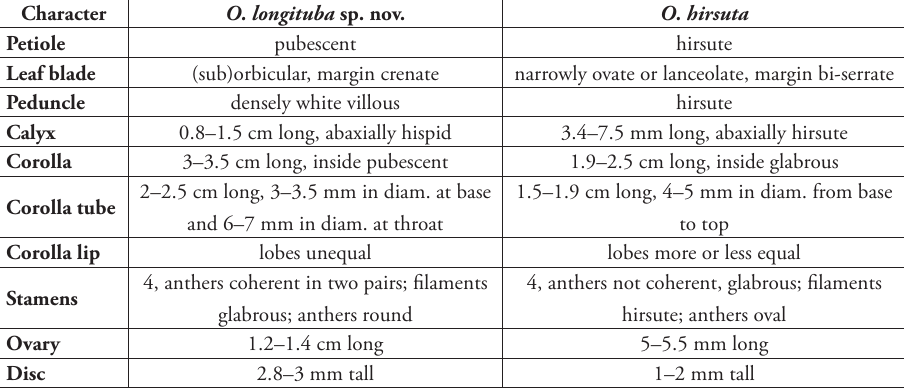
Table 2. Morphological comparison between Oreocharis longituba sp. nov. and O. hirsuta Barnett. Character O. longituba sp.